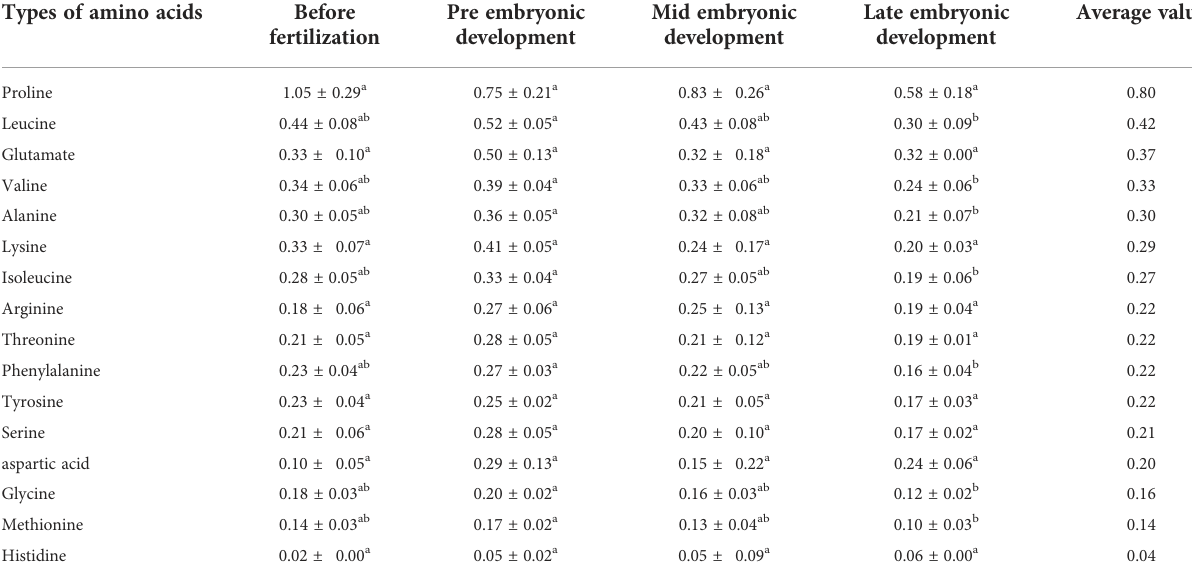
TABLE 3 Plasma amino acids content of three samples of S. schlegelii in different developmental stages (g/100 g). Types of amino acids